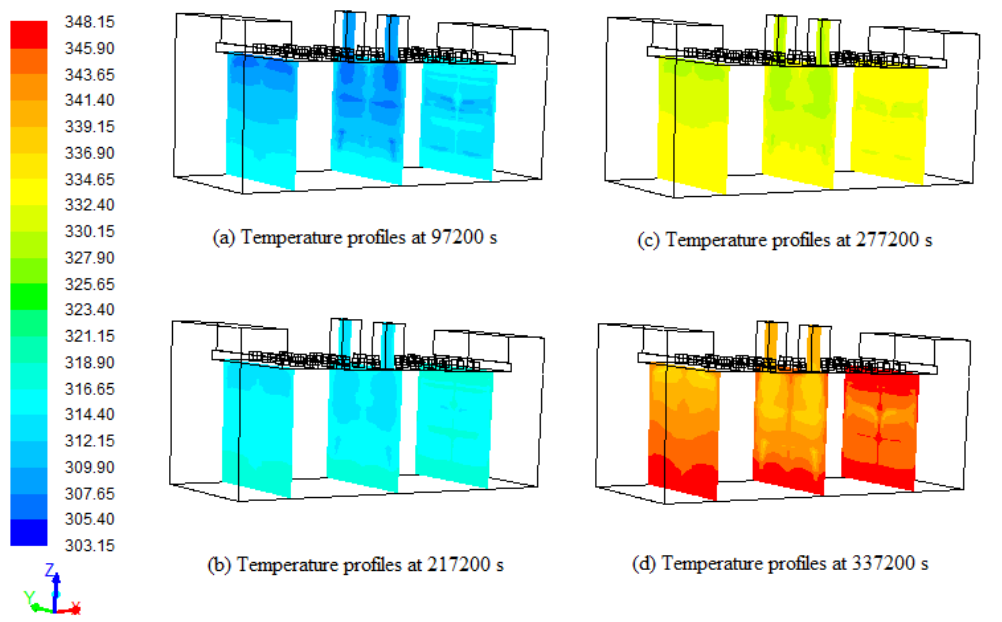
Figure 10. Temperature profiles across three different cross-sections (1.3 m, 4.2 m, and 6.7 m from the left wall) at ( a ) 97,200 s; ( b ) 217,200 s; ( c ) 277,200 s and ( d ) 337,200 s.